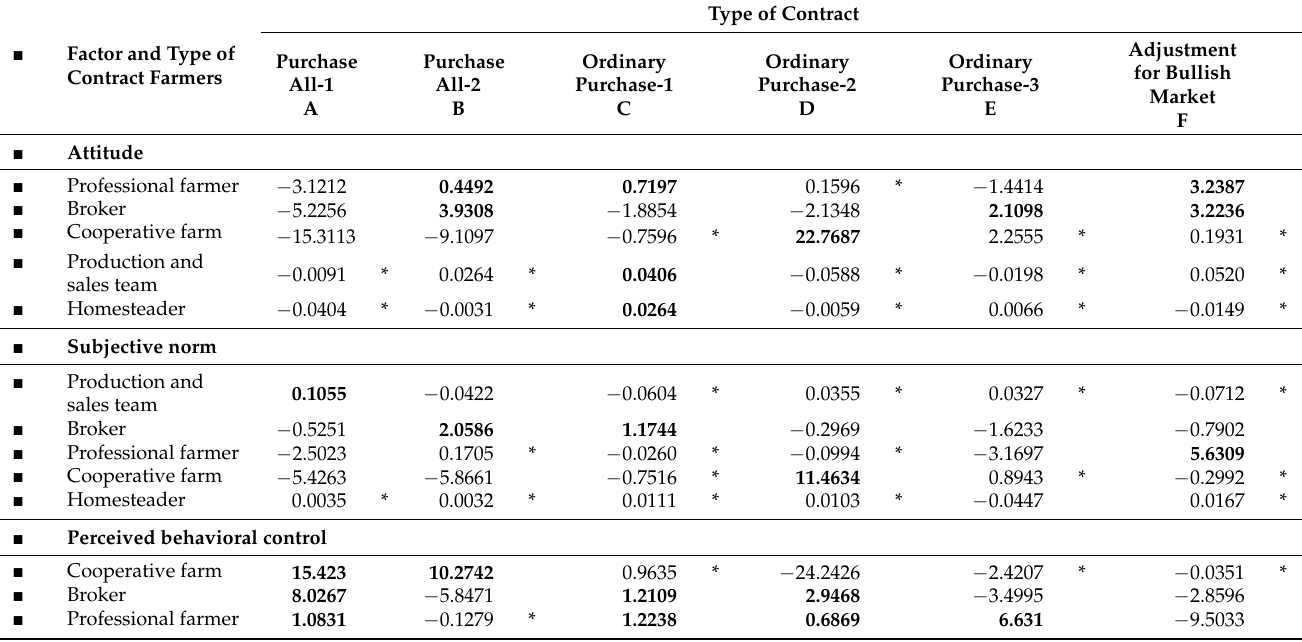
Table 5. Marginal Effects of Different Factors in the TPB on Selecting the Contract Type for Different Types of